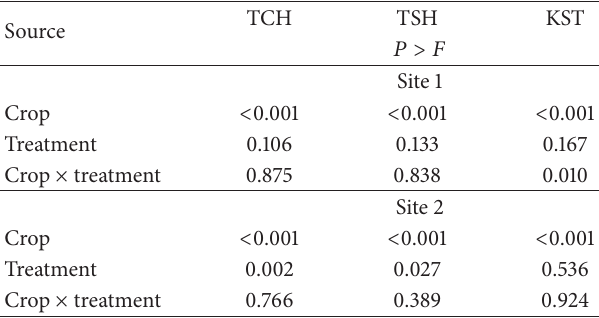
Table 2: For fixed effects in analyses of Sites 1 and 2, 𝑃 > 𝐹 for t cane ha −1 (TCH), t sucrose ha −1 (TSH), and sucrose concentration (KST) a .